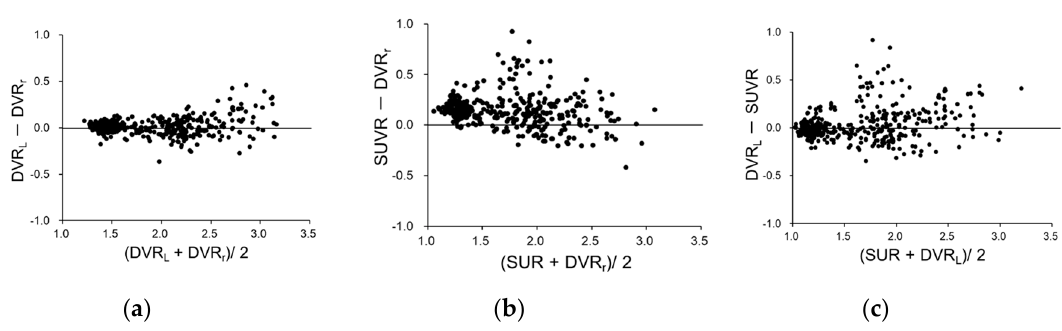
Figure 5. Balnd – Altman plots for DVR r vs. DVR L ( a ), DVR r vs. SUVR ( b ), and DVR L vs. SUVR ( c ) correlation. ( a , b ) are plots after correction with equations of linear regression.